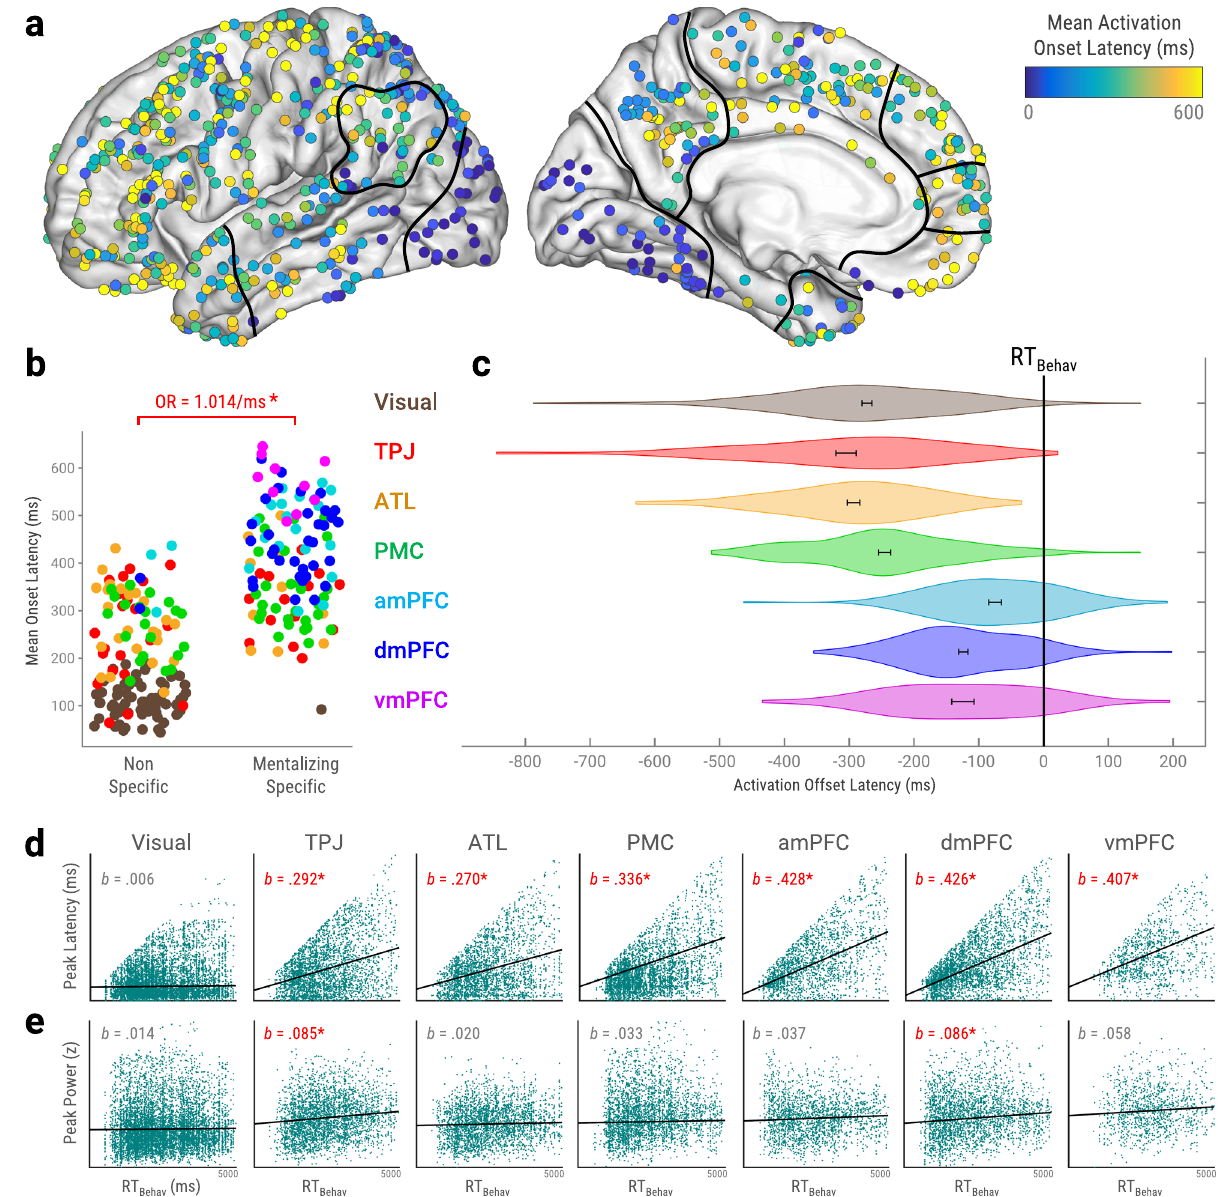
Fig. 4 Spatiotemporal gradients of functional and behavioral relevance for mentalizing. a Mean onset latencies of mentalizing-active sites ( p FDR < 0.05, corrected across timepoints and sites). All sites plotted on left hemisphere with approximate ROI outlines (full views in Supplementary Fig. 8). b Mean activation onset latencies of ROI sites by functional speci fi city (see Fig. 3c). Color indicates ROI. Logistic mixed classi fi cation estimated the odds ratio (OR) of mentalizing-speci fi city over non-speci fi city per millisecond increase in onsets ( p = 9.21e − 11, n = 257 sites). c RT Behav versus ROI activation offset latencies. Error bar indicates standard error of the mean. Offsets in medial prefrontal cortex (mPFC) ROIs more closely preceded RT Behav than other ROIs combined ( b 20204 = 138 ± 31 ms, p = 4.28e − 6, two-tailed), as per post-hoc LMEM. d , e Associations between RT Behav and peak activation metrics within ROIs. Slope estimates ( b ) were controlled for behavioral response choices and stimulus visual dissimilarity via LMEMs. See Table 1 for exact statistics and n . d RT b ) estimate change in peak latency per millisecond increase in RT b = 0) would Behav and activation peak latency. Slopes ( Behav . Horizontal slopes ( indicate purely stimulus-locked activity, while 45° slopes ( b = 1) would indicate purely RT Behav -locked activity (see DiCarlo & Maunsell, 2005 106 ). e RT Behav and peak power (activation magnitude). Slopes ( b ) estimate change in peak power per 1000 ms increase in RT Behav . *Signi fi cant OR and b estimates have red font ( p < 0.05, uncorrected, two-tailed). Abbreviations: RT Behav = behavioral response time. ROI = region-of-interest, Visual = visual cortex, ATL = anterior temporal lobe, TPJ = temporoparietal junction, PMC = posteromedial cortex, amPFC = anteromedial prefrontal cortex, dmPFC = dorsomedial prefrontal cortex, vmPFC = ventromedial prefrontal cortex, z = z-score, LMEM = linear mixed-effect model. Source data are provided as a Source Data fi